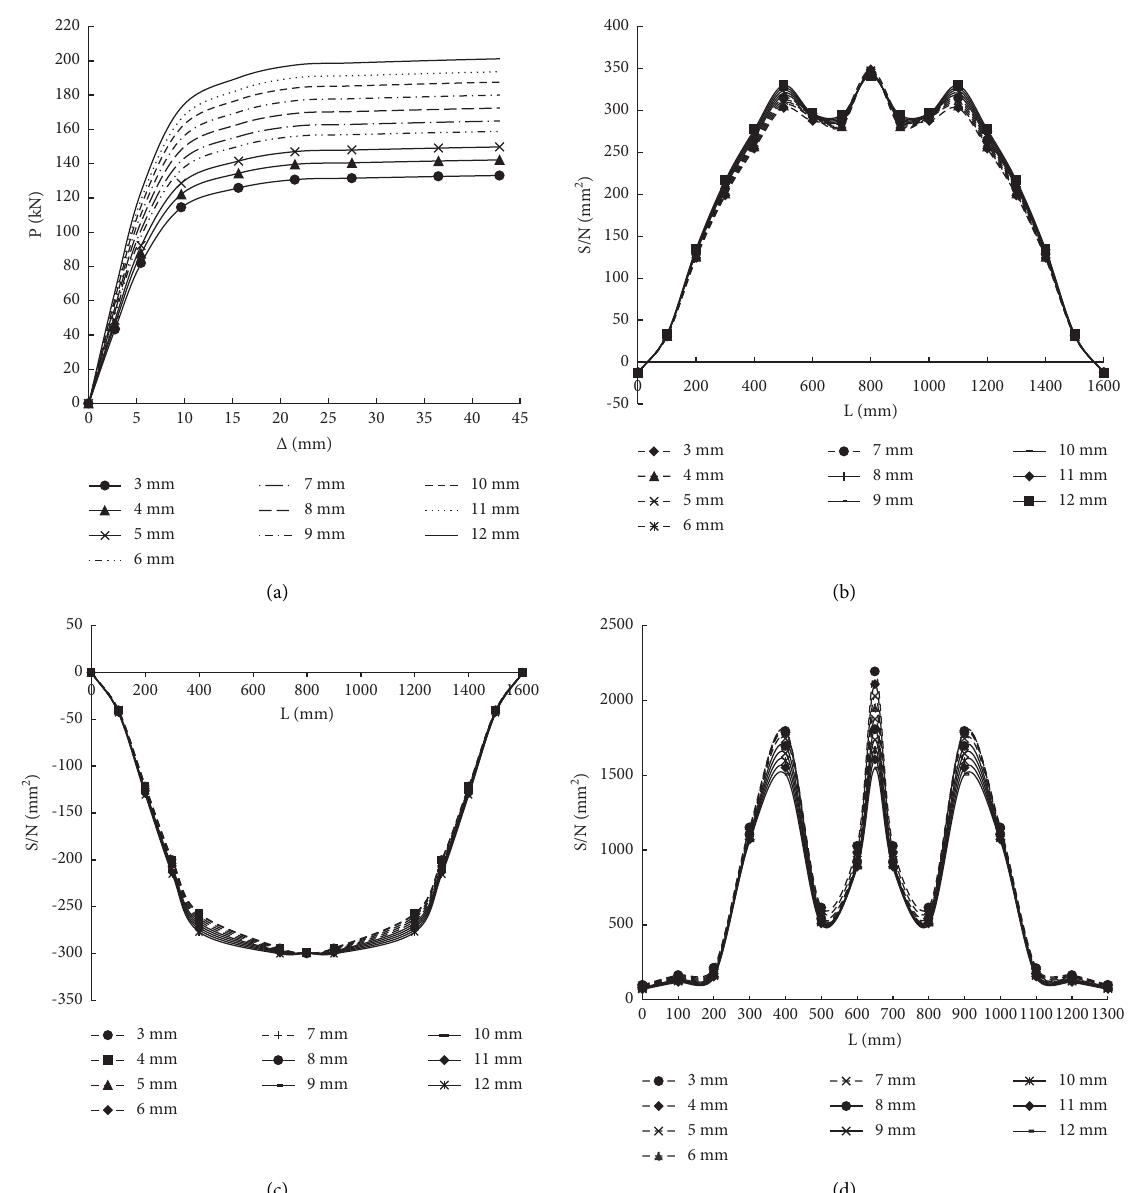
Figure 17: Effect of web thickness. (a) Load and deflection. (b) Stress along steel beam length. (c) Stress along steel beam width. (d) Stress along CFRP sheet’s